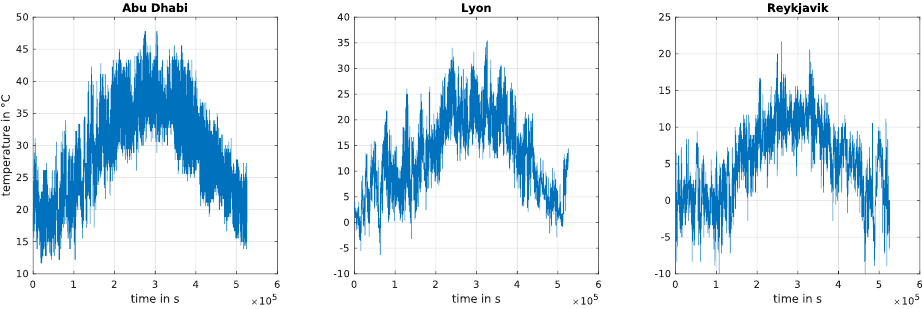
Figure 5. External temperature along the year 2021 for different